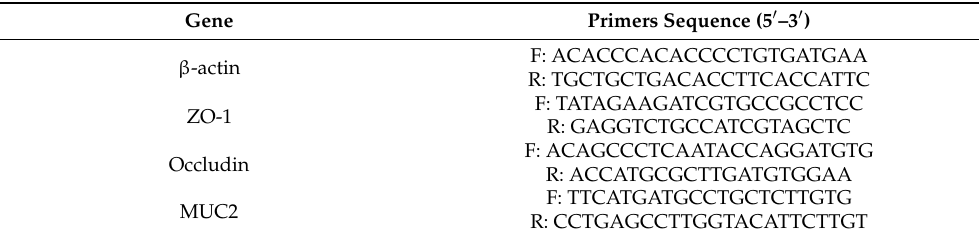
Table 2. Gene name, primer